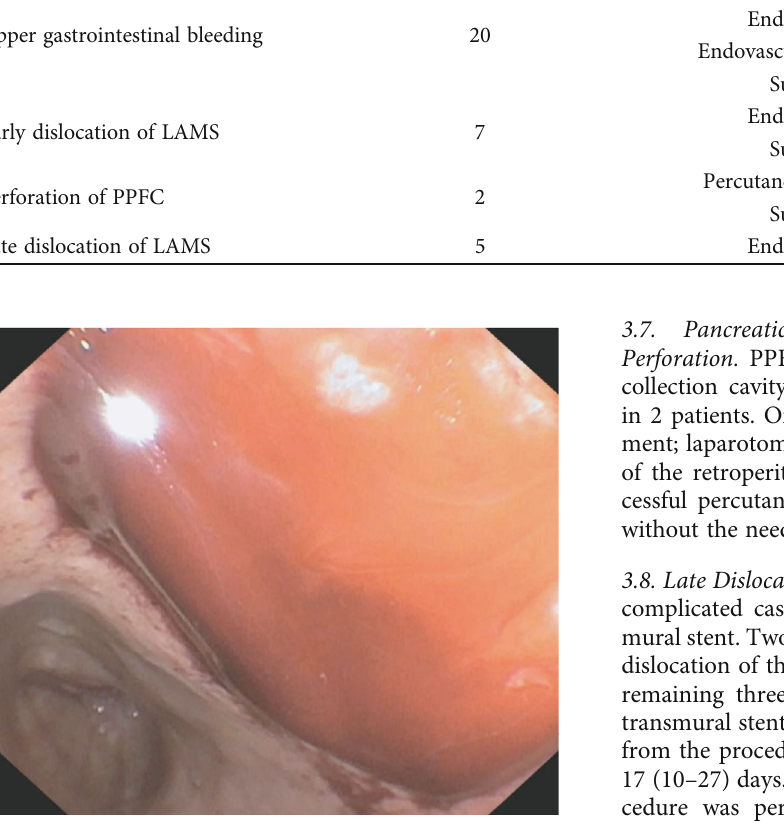
Figure 11: Endoscopic image (gastroscopy). Arterial bleeding from the collection cavity through the transmural LAMS into the gastric